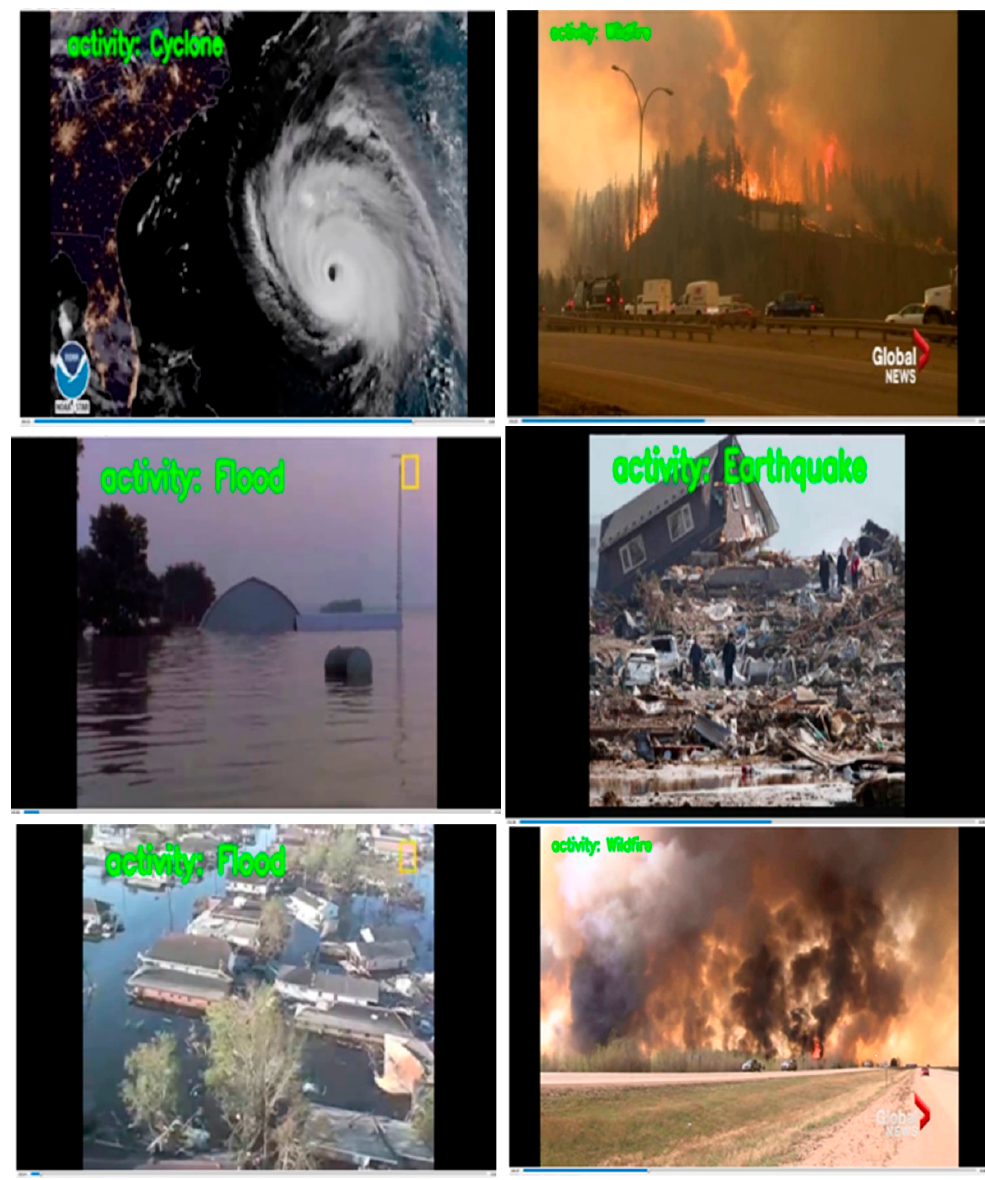
Figure 23. Severe weather events detection and classification.